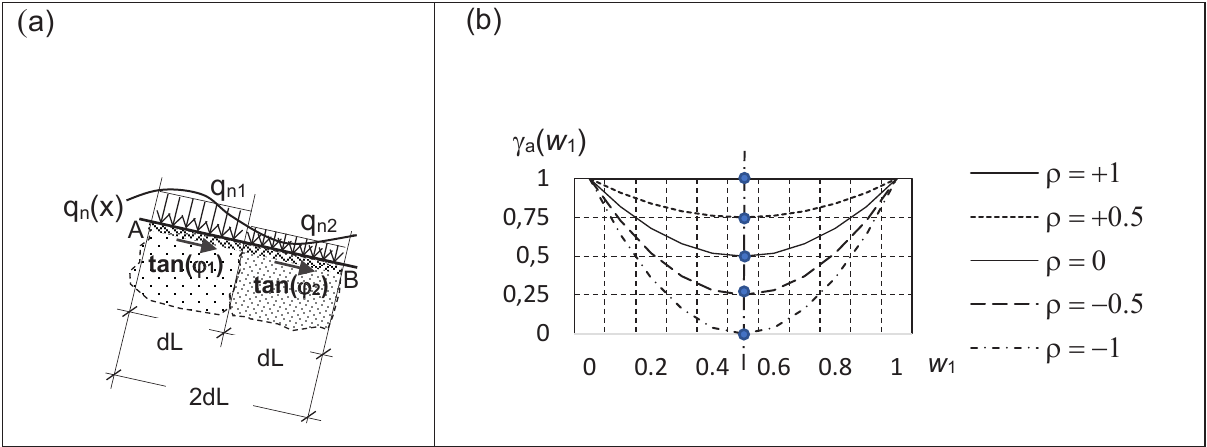
), i = 1, 2. (b) Variance reduction factors g i